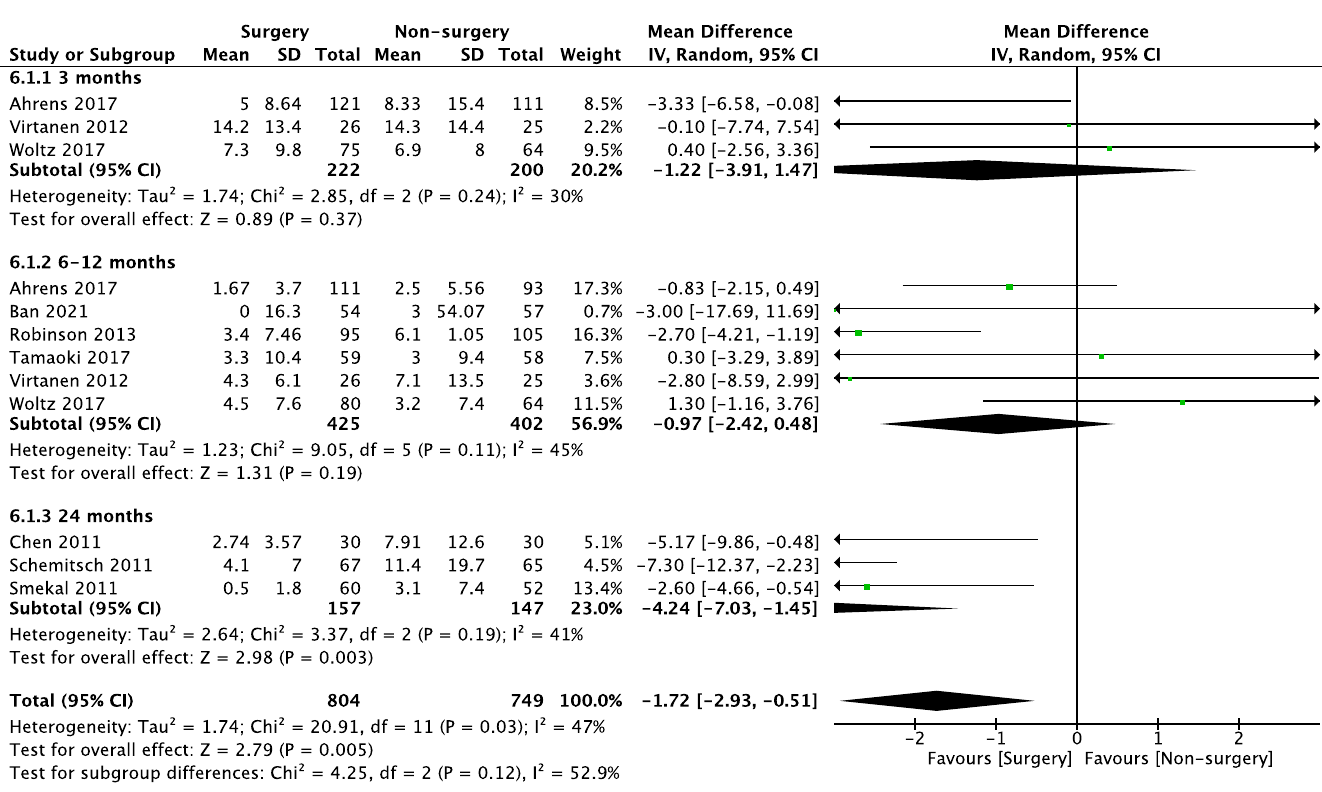
Fig 4. Meta-analysis of mean difference of DASH score between surgical intervention and non-surgical intervention in the pooled studies. Overall -1.72 (95% CI -2.93 to -0.51; p = 0.005); early (3-months) -1.22 (95% CI -3.91 to 1.47; p = 0.37); intermediate (6–12 months) -0.97 (95% CI -2.42 to 0.48; p = 0.19); late (24 months) -4.24 (95% CI -7.03 to -1.45; p =